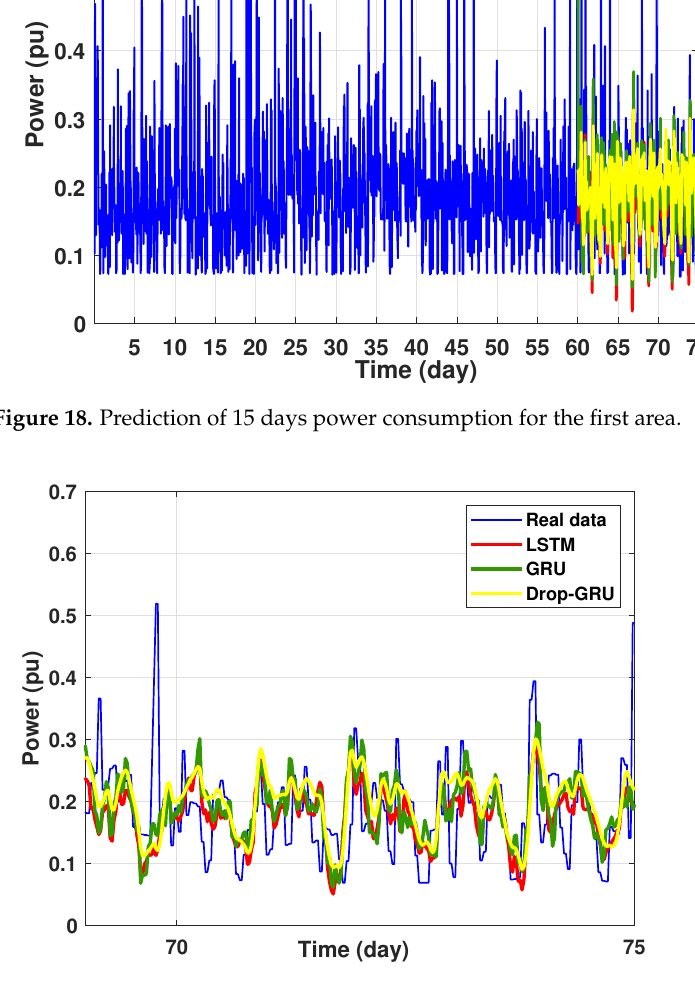
Figure 19. Zoom version Prediction of 15 days power consumption for the first